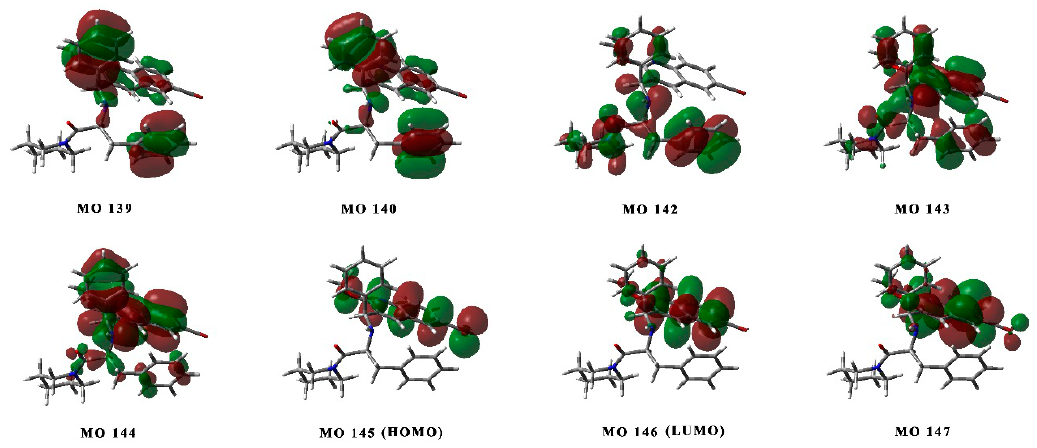
Figure 3. Molecular orbitals involved in the electronic transitions of 1 .